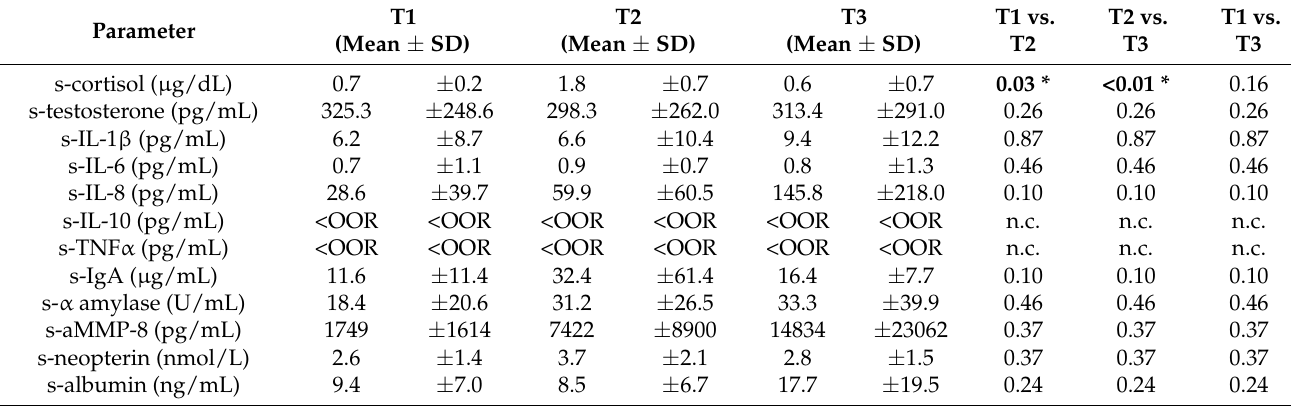
Table 2. Salivary parameters at baseline (T1), shortly after the ultramarathon (T2), and after recovery (T3) and p -value for differences between time points. The p -values indicate the longitudinal differ- ences calculated by the Friedman test and, in case of significant differences, by Dunn’s pairwise post hoc test. Bold values and an asterisk mark the significant differences ( p < 0.05).